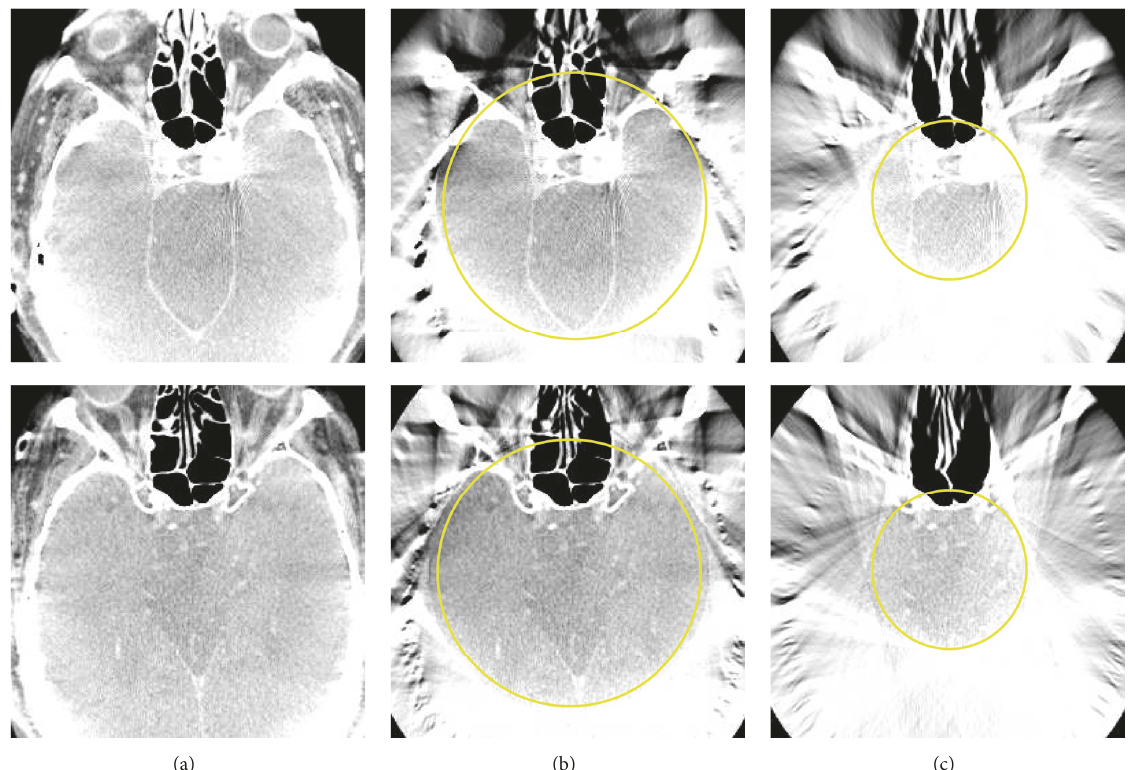
Figure 8: Reconstruction results of the reprojected clinical datasets 1 and 2 with both medium truncation (b) and severe truncation (c). Yellow circle indicates the ROI. The grayscale window: 𝐶 = 0HU, 𝑊 =